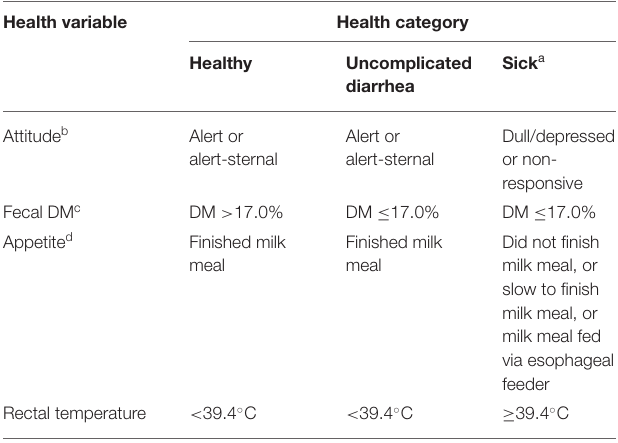
TABLE 1 | Post-enrollment health score criteria for categorizing healthy and sick calves at enrollment during pre-weaned period. Health